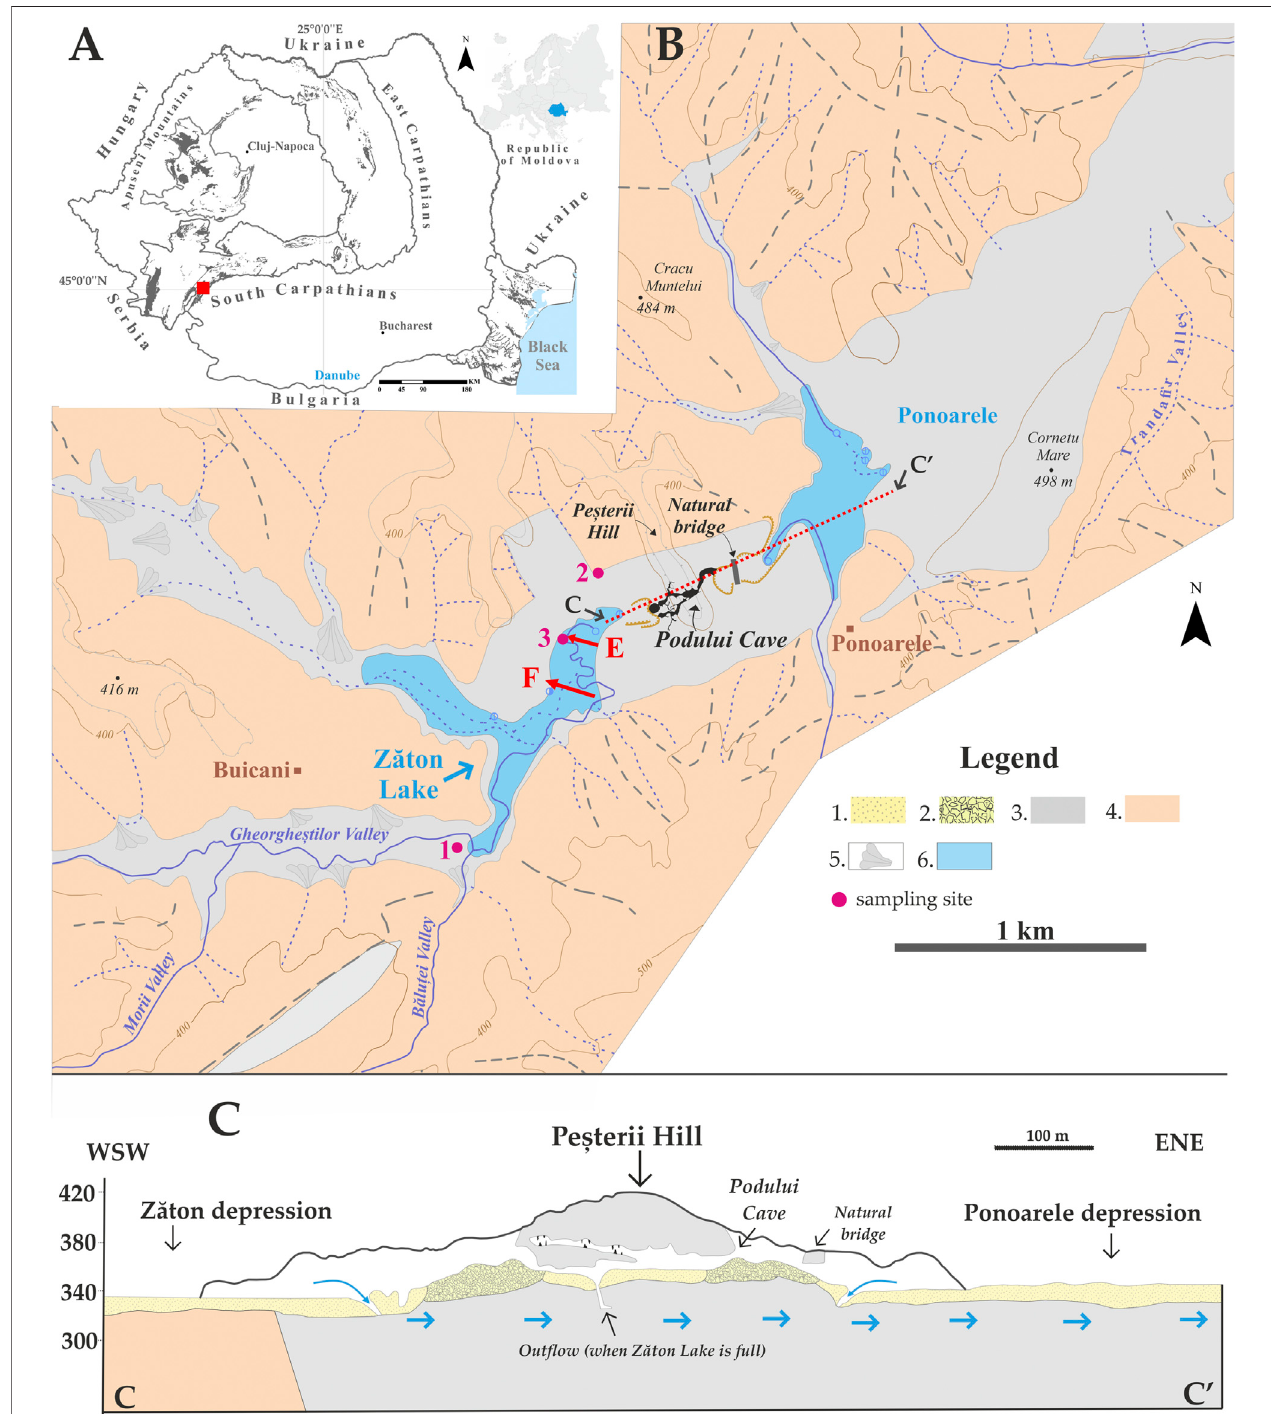
FIGURE 1 | (A) Location of the Z ă ton Basin in the S.W. part of the Romanian Carpathians. (B) Z ă ton Lake and the connected cave system. (C) Schematic representation ofthelongsection ofthecavesystemandits functioningwhenZ ă tondepression fi lls withwater.TheEandFpositionsofthetwogeophysical pro fi lesare marked with red arrows. 1 = quaternary sediments; 2 = scree debris; 3 = limestone; 4 = impervious rocks; 5 = talus fan; and 6 = lake. (B,C) Modi fi ed from Goran, 1978.